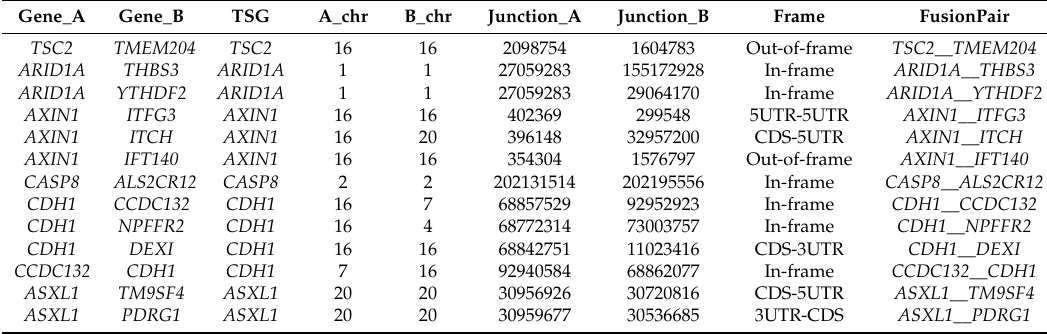
Table 1. Fusion Gene Transcripts involving Tumor Suppressor Genes in Breast